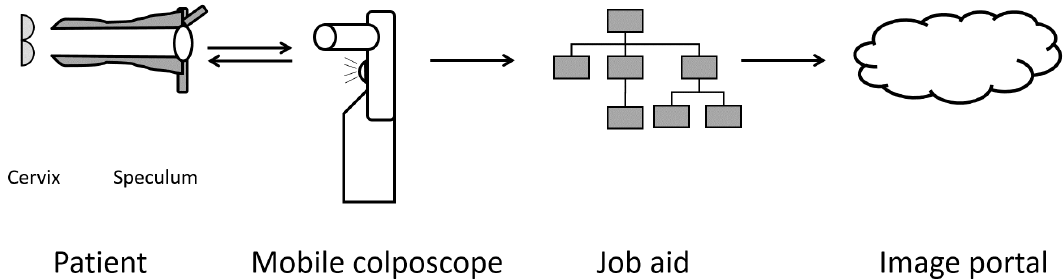
Figure 3. Visual inspection with acetic acid (VIA) clinical workflow with the EVA System. Light from the mobile colposcope illuminates the cervix (through the opening of a speculum). The nurse records images and makes a clinical decision using the guided workflow job aid. The images and clinical decision are uploaded to the cloud-based image portal.